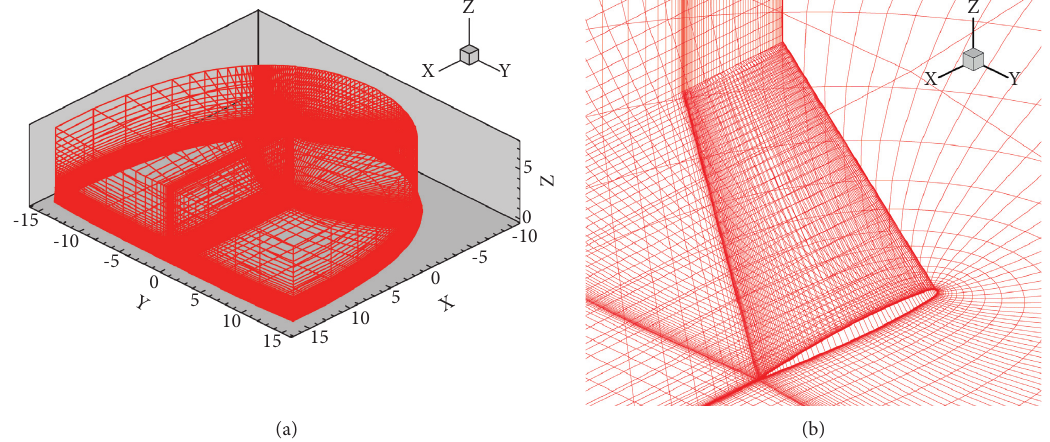
Figure 10: Mesh for ONERA-M6 wing. (a) Full view. (b) Local mesh around the